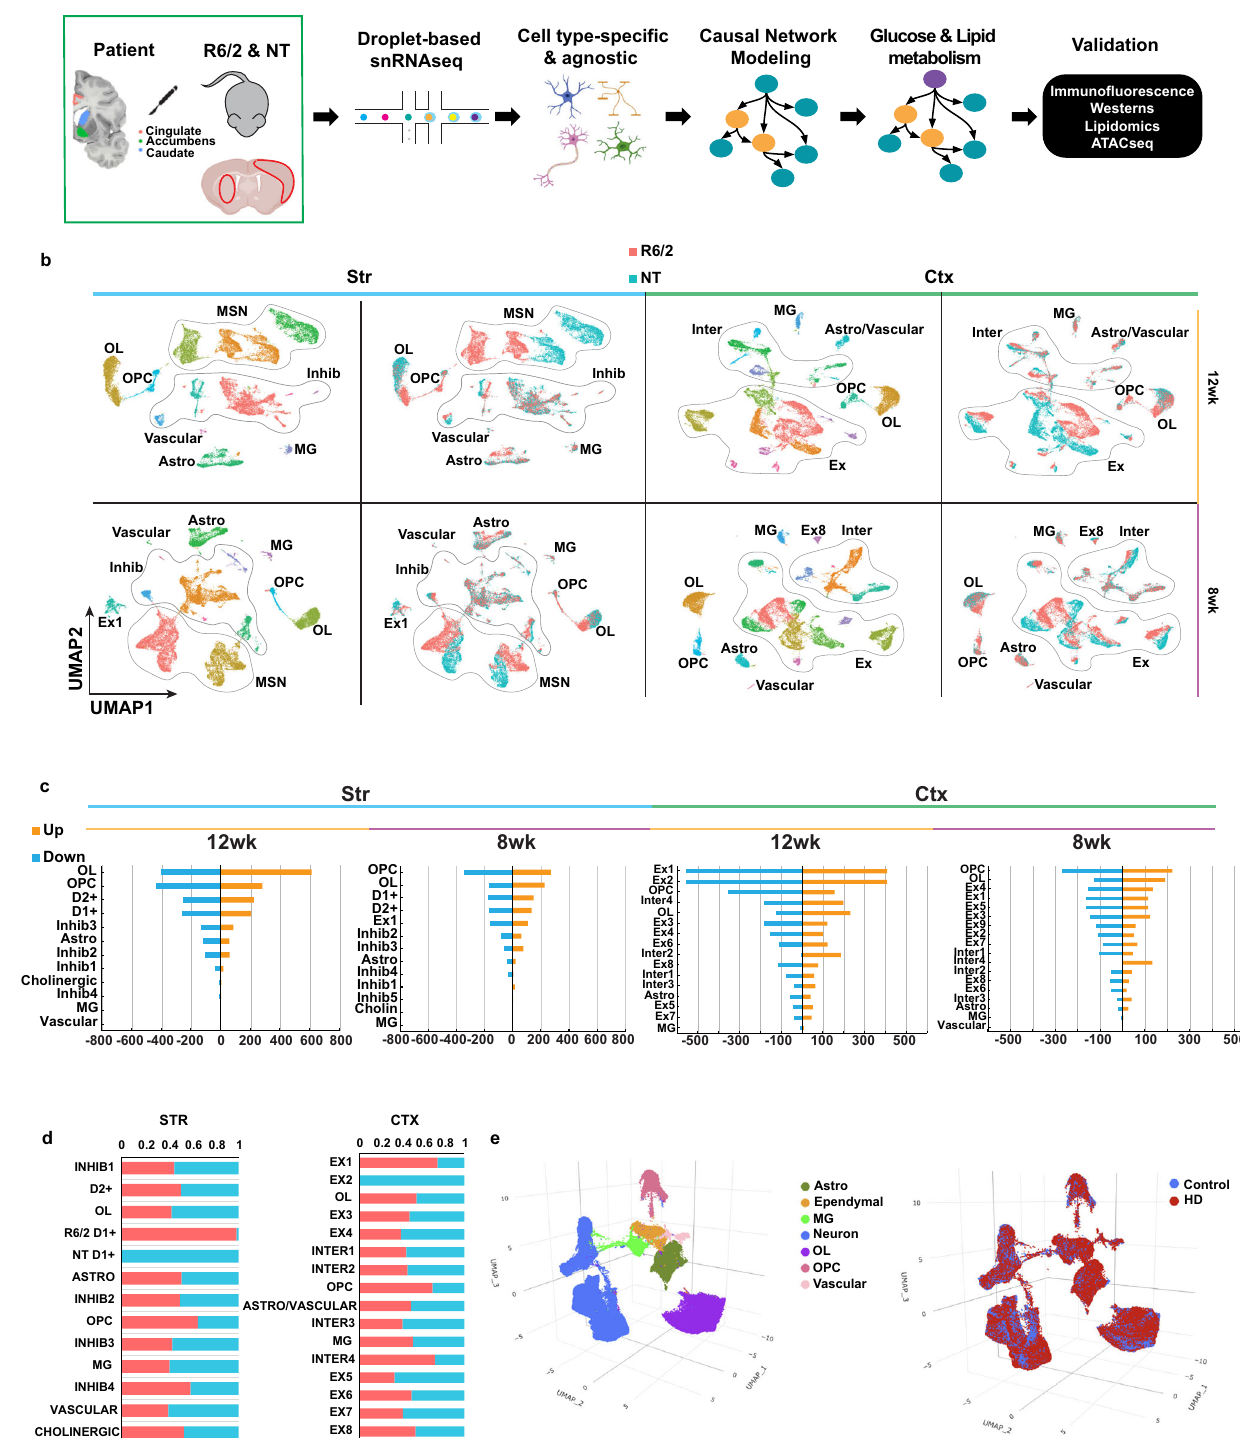
Fig. 1 | Single nucleus RNAseq of mouse and human R6/2 and HD samples. a Illustration of work fl owused for thisstudy. Afterfrozen tissue is microdissected from the Cingulate, Caudate, and nucleus Accumbens from 66 samples from 29 humandonors(3gradeI,4gradeII,4gradeIII,3gradeIV,5juvenile-onsetHD,and 10 matched controls), or the striatum and cortex of the mice ( n =3), nuclei are isolated, 10× Libraries are prepared followed by next generation sequencing. Created with BioRender.com b Uniform manifold projection and approximation plots(UMAP)oftheR6/2andNTmousedatacoloredbyclusterorgenotype.Initial QC and fi ltering led to the identi fi cation of 108,974 nuclei from mouse tissues.